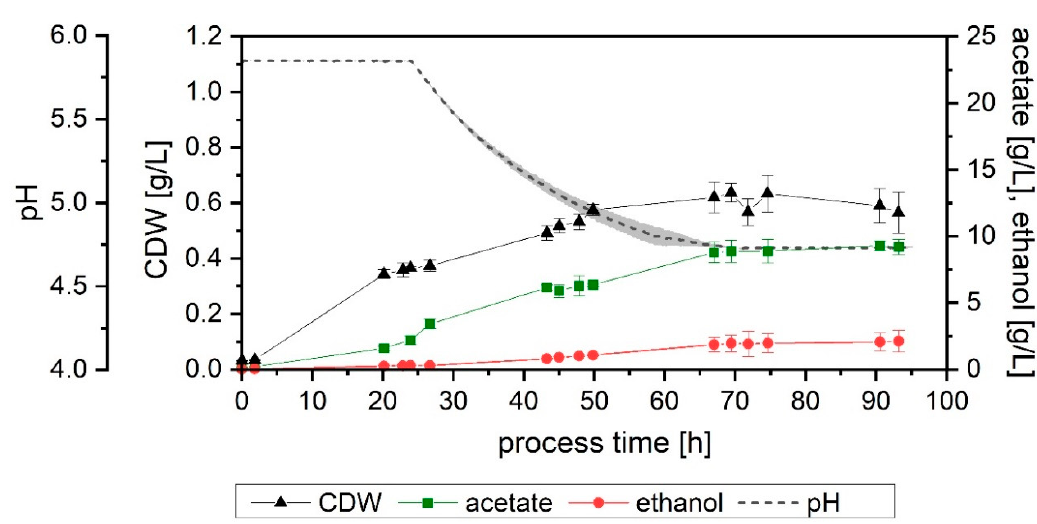
Figure 5. Growth, pH profile and product formation of Setup 6 with pH allowed to drop to 4.8 and gas flow decreased to 12.6 mL / min after 24 h. Average values of the triplicates ( n = 3) with STD for cell dry weight (CDW, black triangles), acetate (green squares), ethanol (red dots) and pH (grey dotted line). The lightly colored area around the pH average represents the standard deviation. For CDW, acetate and ethanol points indicate actual measurements, while lines are only depicted for clarity purposes. pH was measured on-line.